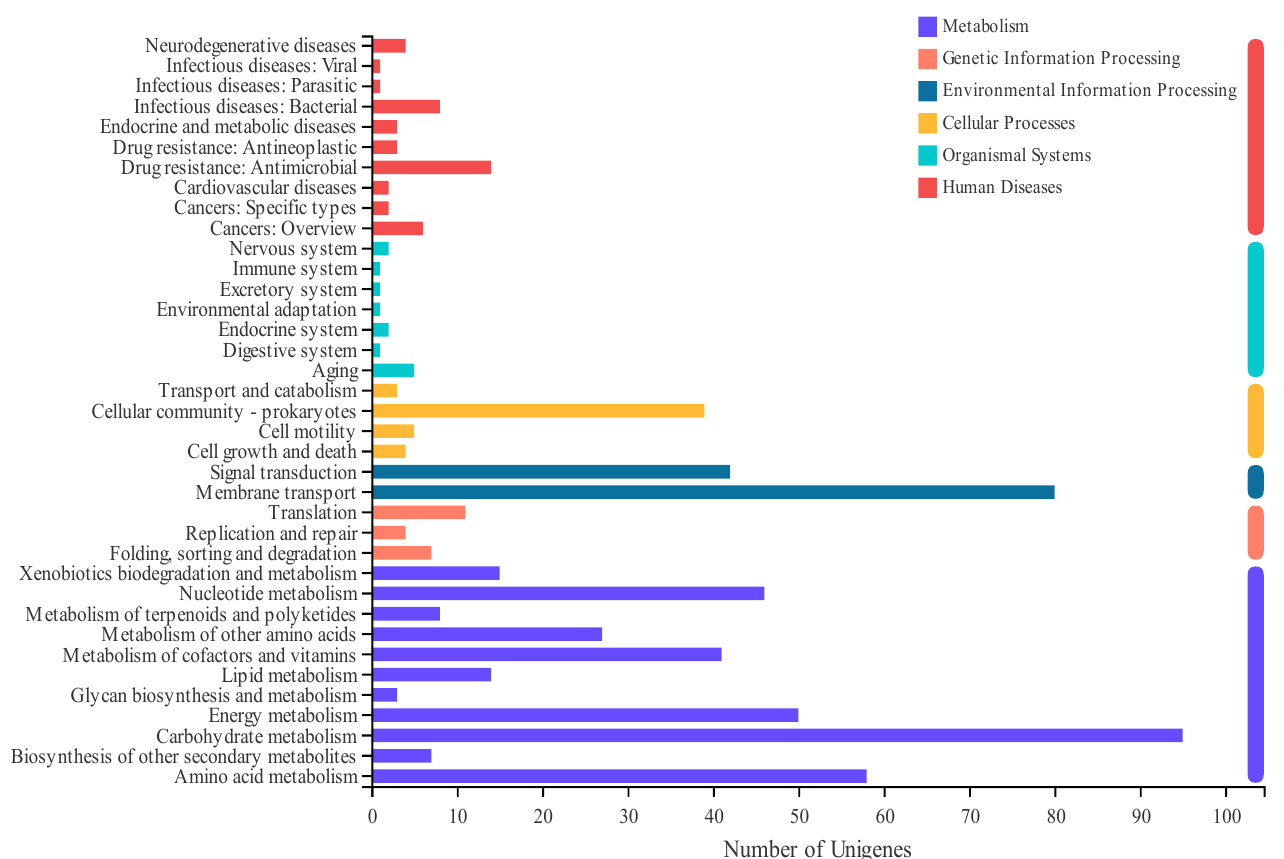
Figure 5. KEGG histogram of DEG. The ordinate is the name of the KEGG metabolic pathway, and the abscissa is the number of genes annotated to the pathway.